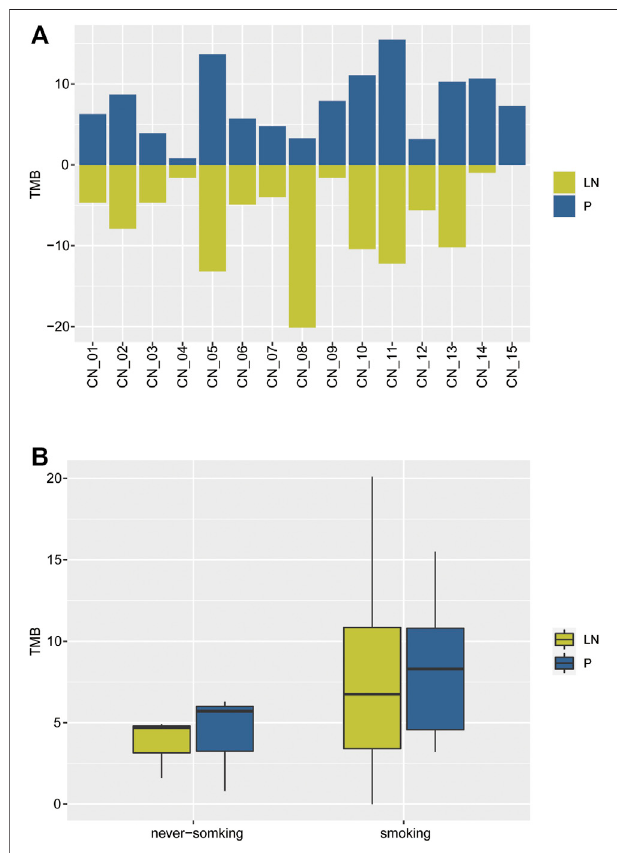
FIGURE 2 | The distribution of TMB of the NSCLC paired samples. (A) The comparison of TMB between primary and lymph nodes metastatic samples. (B) The comparison of TMB in primaries and lymphatic metastases between smoking and never-smoking NSCLC